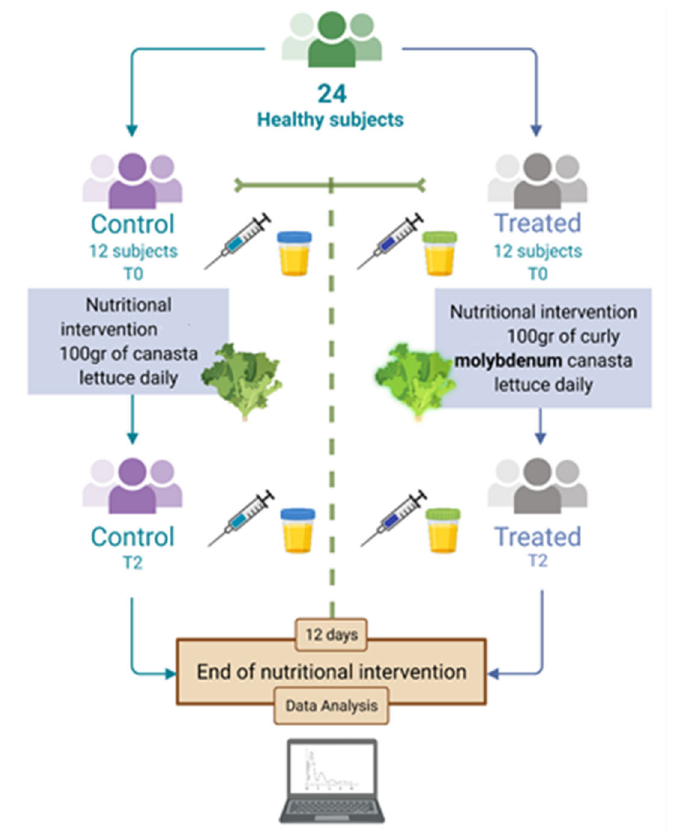
Figure 1. Flow chart of the interventional nutritional study during the period of 12 days of administration of biofortified molybdenum canasta lettuce and lettuce without any biofortification. Control = control group eating canasta lettuce with no biofortification, Treated = treated group eating lettuce biofortified with molybdenum.